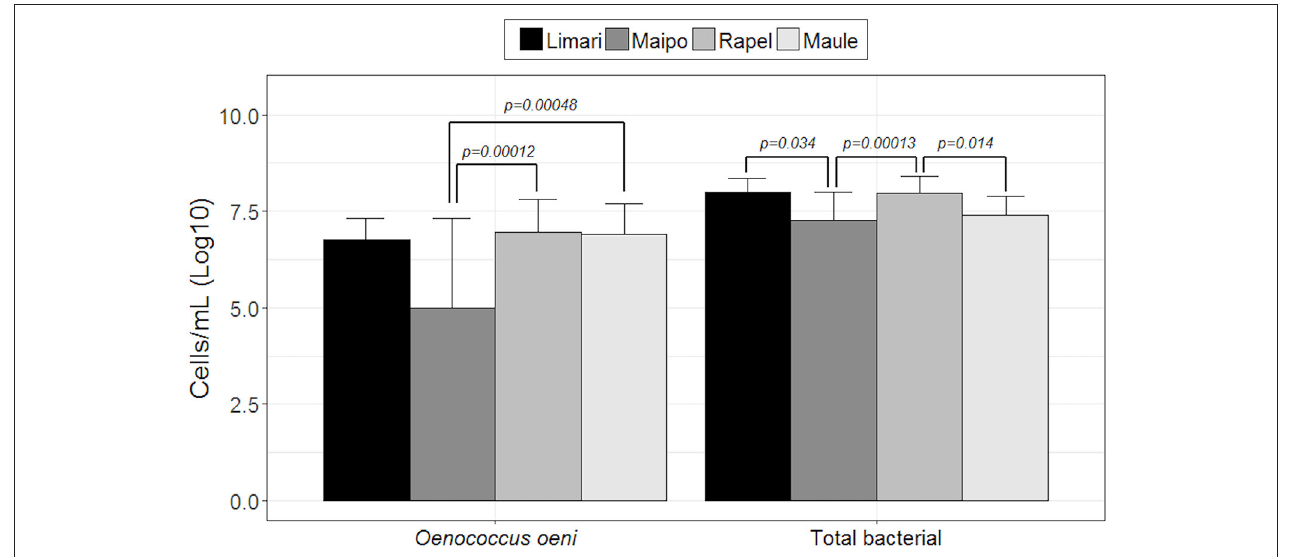
FIGURE 1 | Total bacterial and O. oeni load quantified by qPCR in wine from spontaneous MLF different valleys examined (log 10